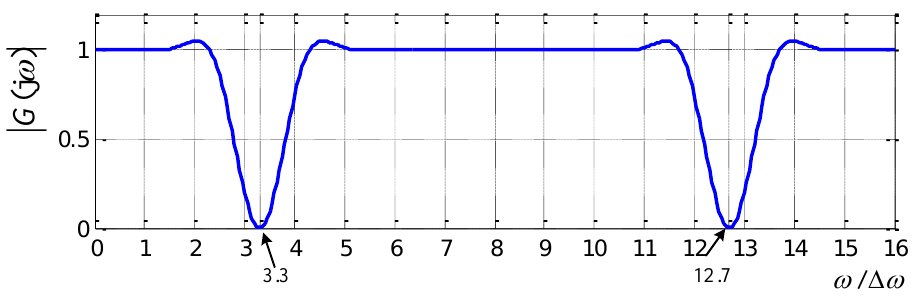
Figure 5. Transfer curves of two sub-filters ( N = 16, m = 3, λ = 0.3): ( a ) sub-filter g (cid:48)(cid:48) From Figure 5, it is verified that the notching frequencies | G (cid:48)(cid:48) located at the expected positions 3.3 ∆ ω , 12.7 ∆ ω .